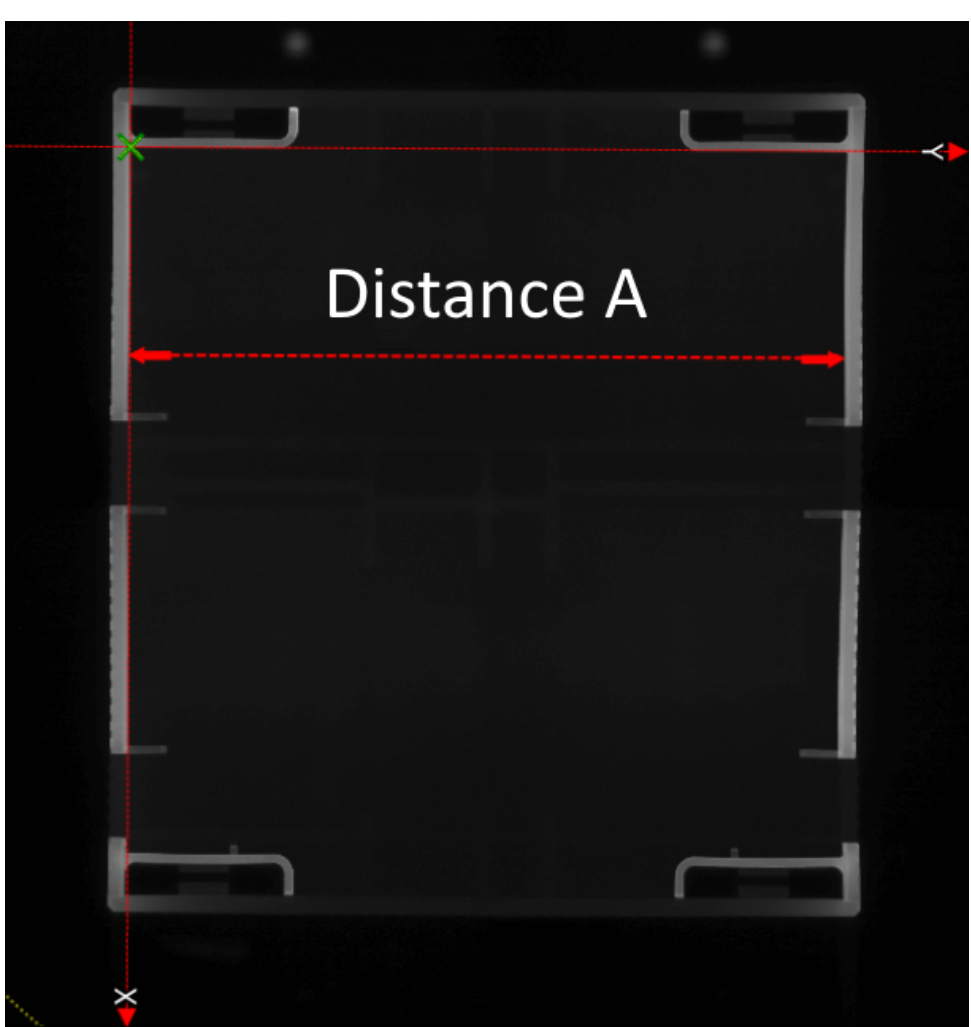
Figure 3. Geometrical measurement at X = 65mm (top